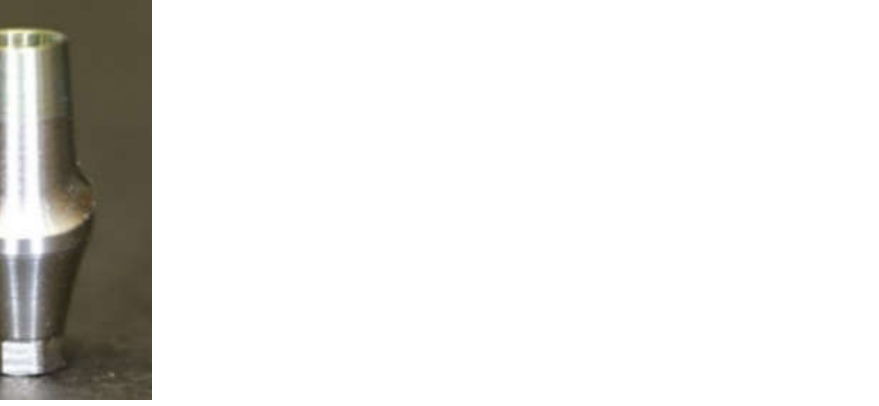
Figure 2. Titanium prototype abutment (NobelReplace Abutment Conical Connection RP 3 mm).